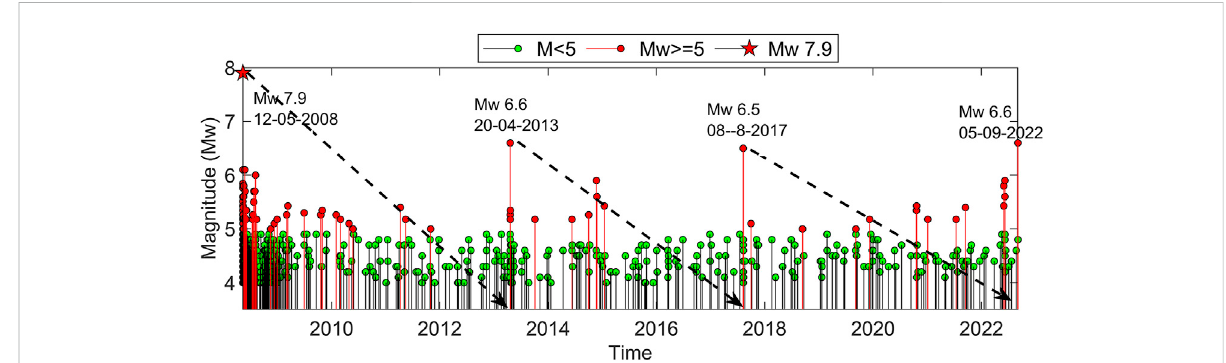
FIGURE 5 Earthquakes of4 < Mw < 5(green fi lled dots)and Mw ≥ 5(red fi lleddots) occurringwithin the300 kmradius ofthe2008Sichuan earthquakes for the period 12 May 2008 through 05 September 2022. After the Sichuan earthquake, earthquakes of Mw ~ 6.5 occurred at an interval of ~4 – 5 years, the latest being of Mw 6.5 on 5th September 2022.